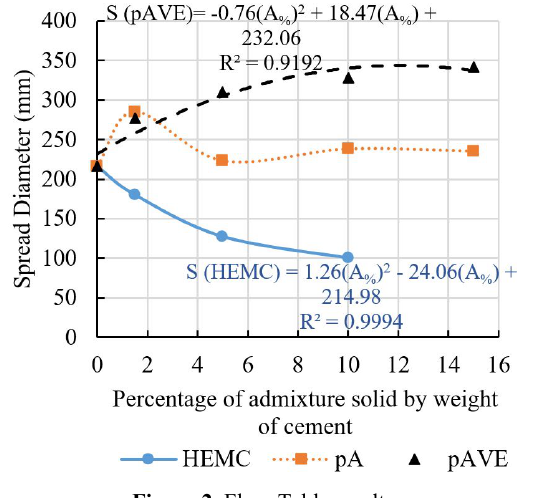
Figure 2. Flow-Table results.